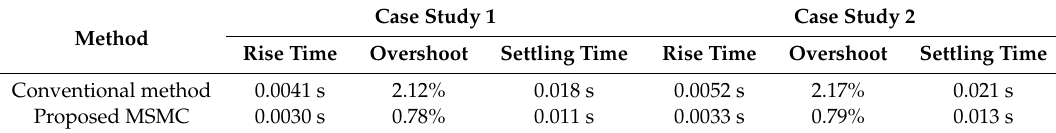
Table 6. Dynamic response performance comparison regarding active power support.